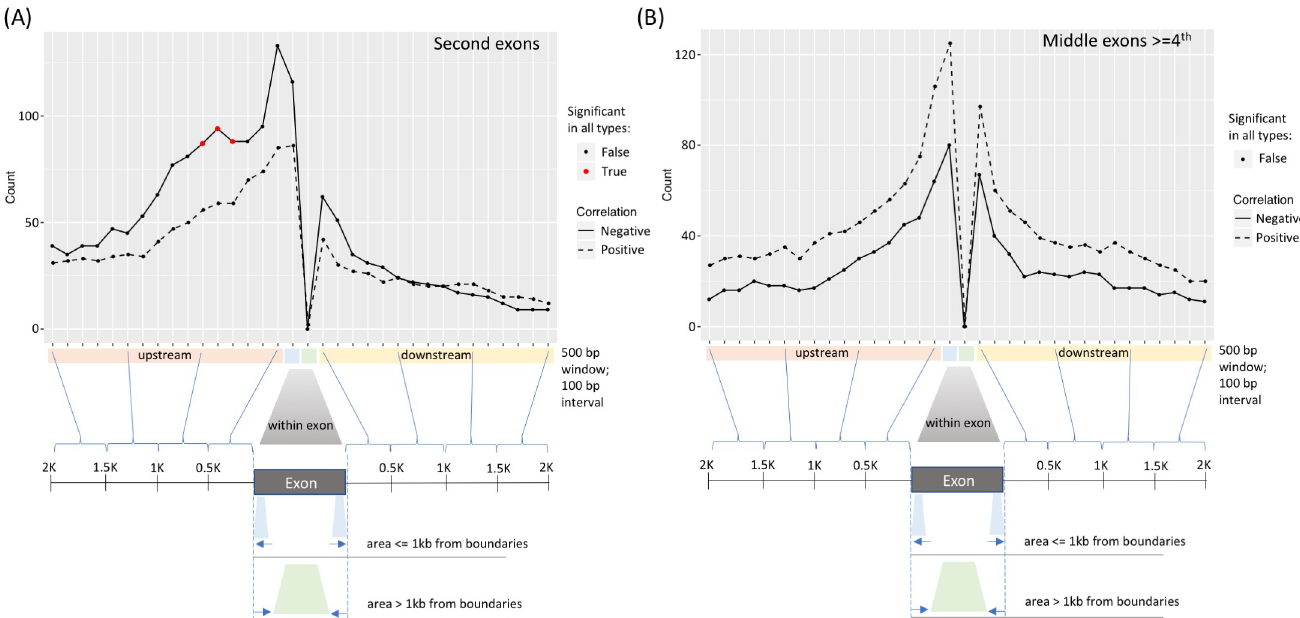
Fig 2. Negative correlations occur upstream of second exons, whereas positive correlations occur at the fourth position or later. (A) The median count (among 11 cancer types) of positive and negative correlations computed for each binned region inside and around the middle exons in the second position in the exon- intron isoform structure. Negative correlations in the upstream were interpreted as TSS-related repression. (B) The same plot as in (A) but for middle exons in the fourth or later position, showing majority of positive correlations. Significance across all cancer types was not detected in the fourth exon (or later)